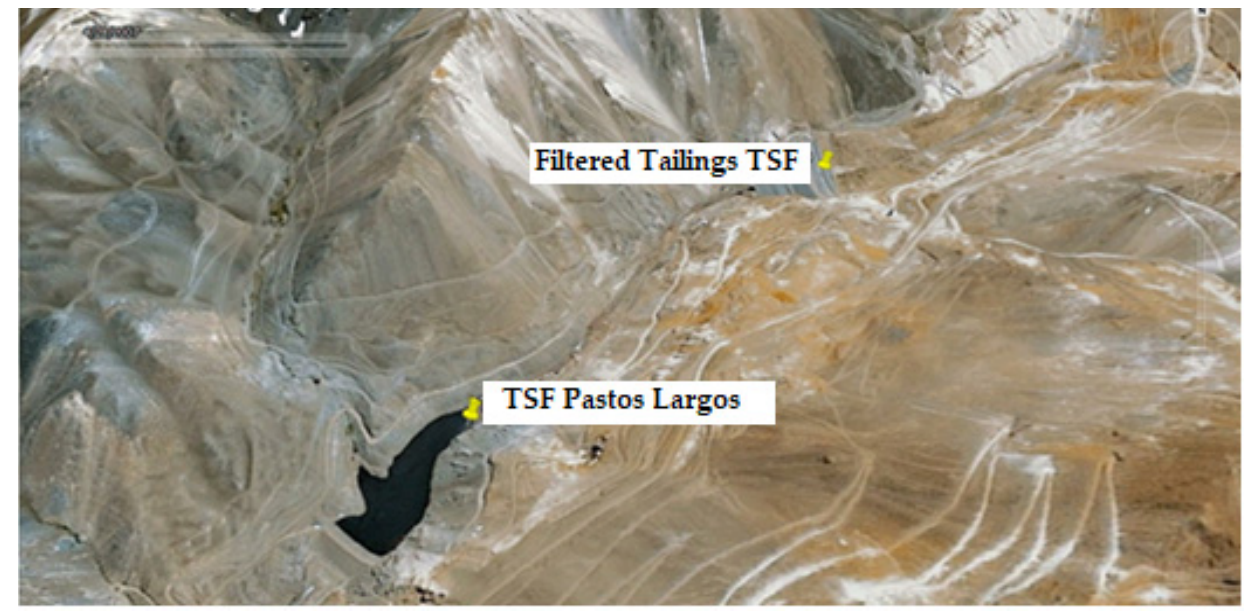
Figure 21. El Indio Filtered TSF Front View [53].